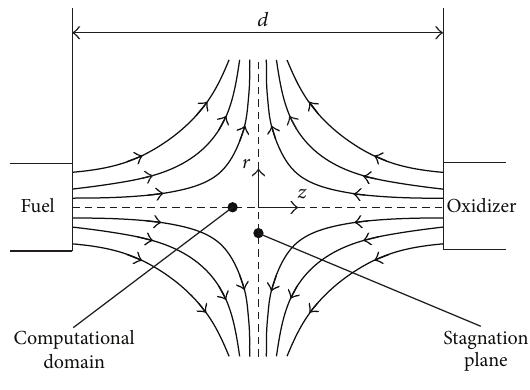
Figure 1: Schematic view of the counterflow flame